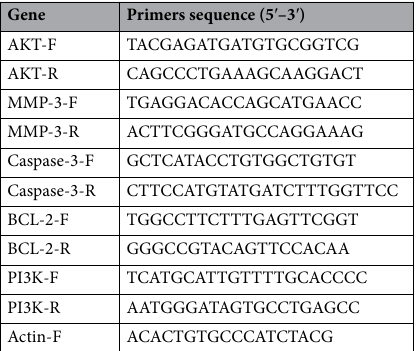
Table 2. Primers sequence in the qRT-PCR